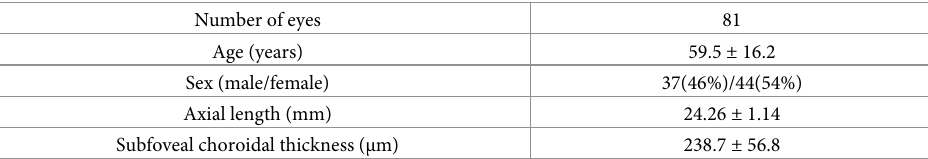
Table 1. Characteristics of the study